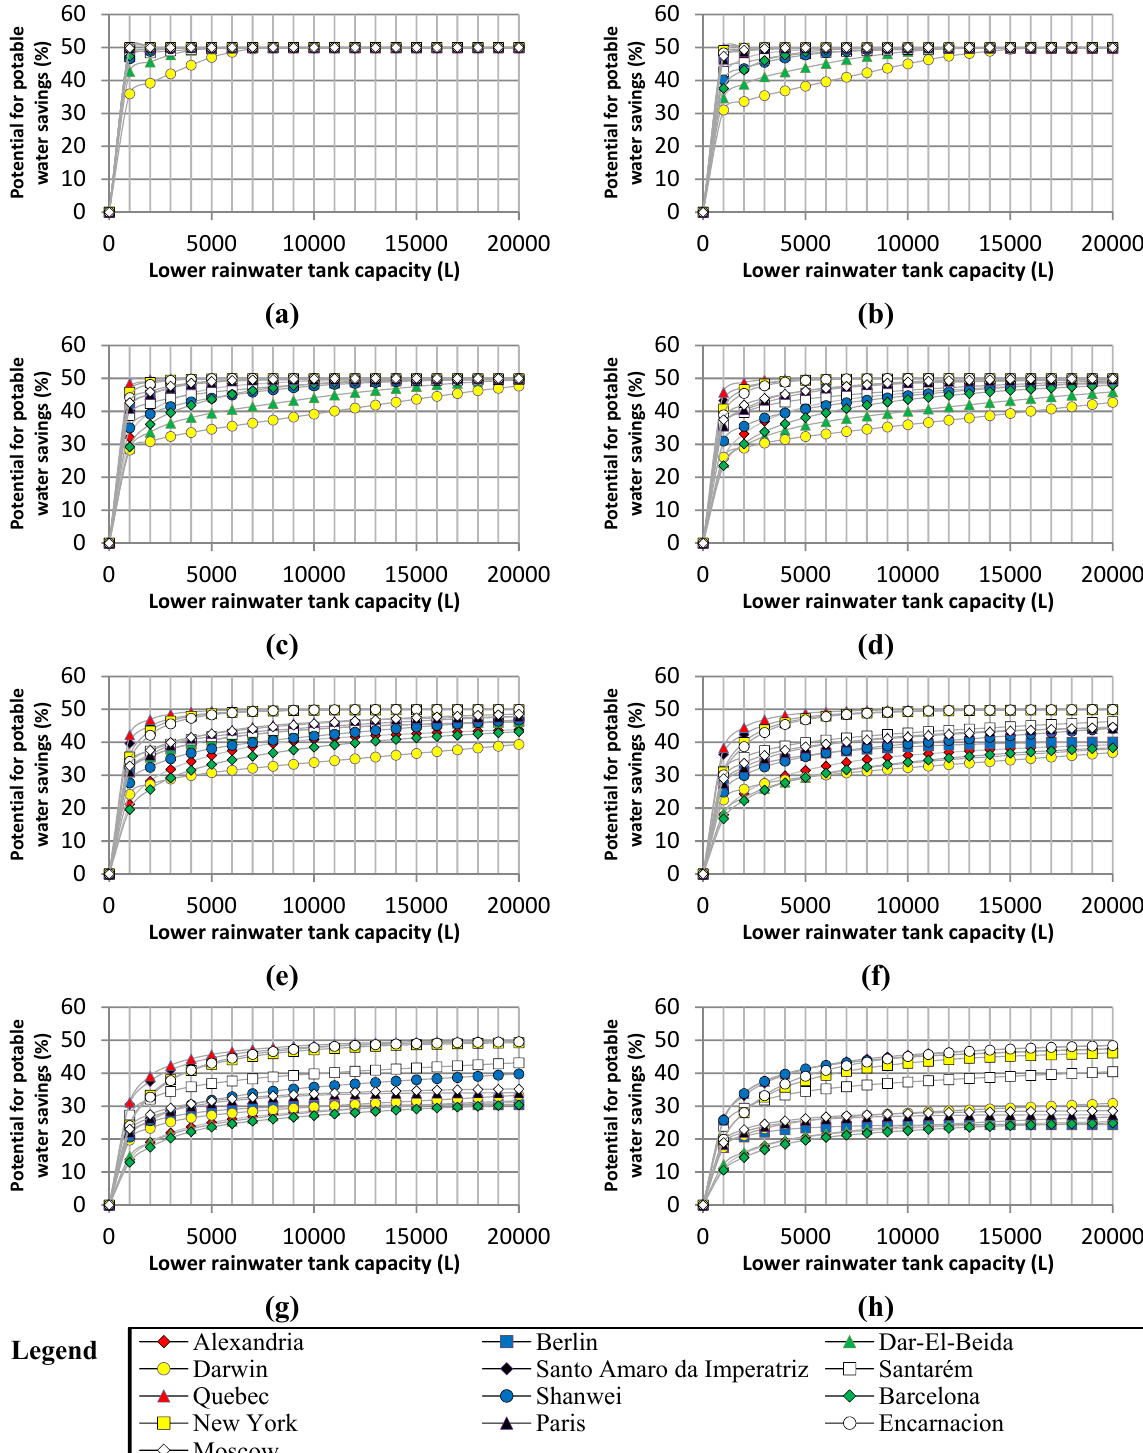
Figure 6. Potential for potable water savings for each city as a function of rainwater demand and catchment surface area of 200 m 2 . (a) Rainwater demand of 50 L per house per day. (b) Rainwater demand of 100 L per house per day. (c) Rainwater demand of 150 L per house per day. (d) Rainwater demand of 200 L per house per day. (e) Rainwater demand of 250 L per house per day. (f) Rainwater demand of 300 L per house per day. (g) Rainwater demand of 400 L per house per day. (h) Rainwater demand of 500 L per house per